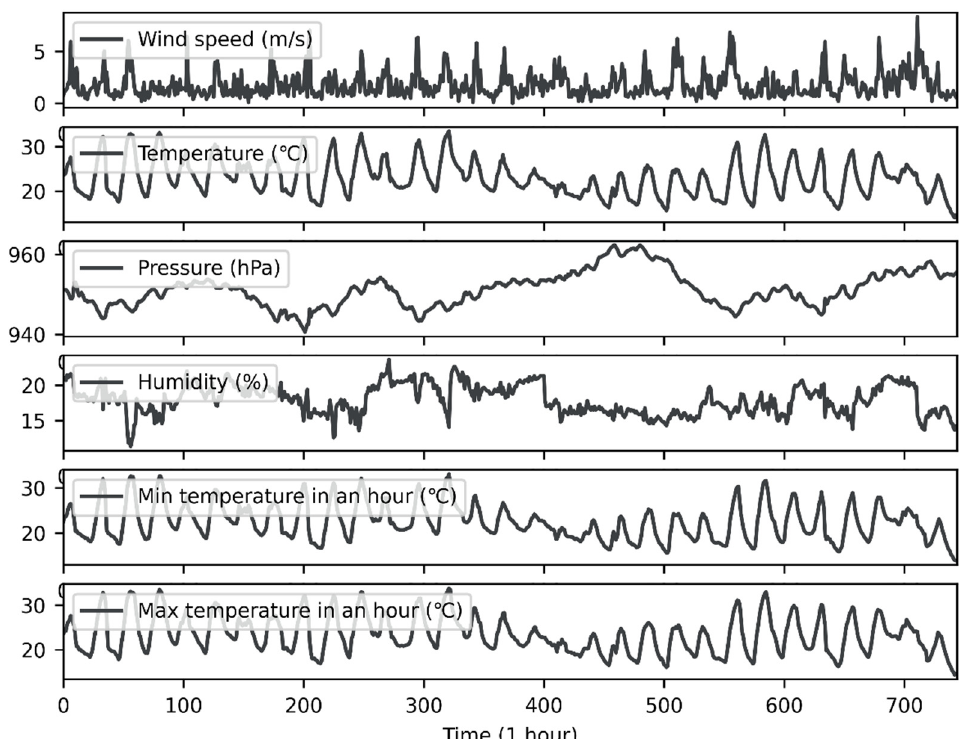
Figure 2. Real meteorological data from Yanqing station.